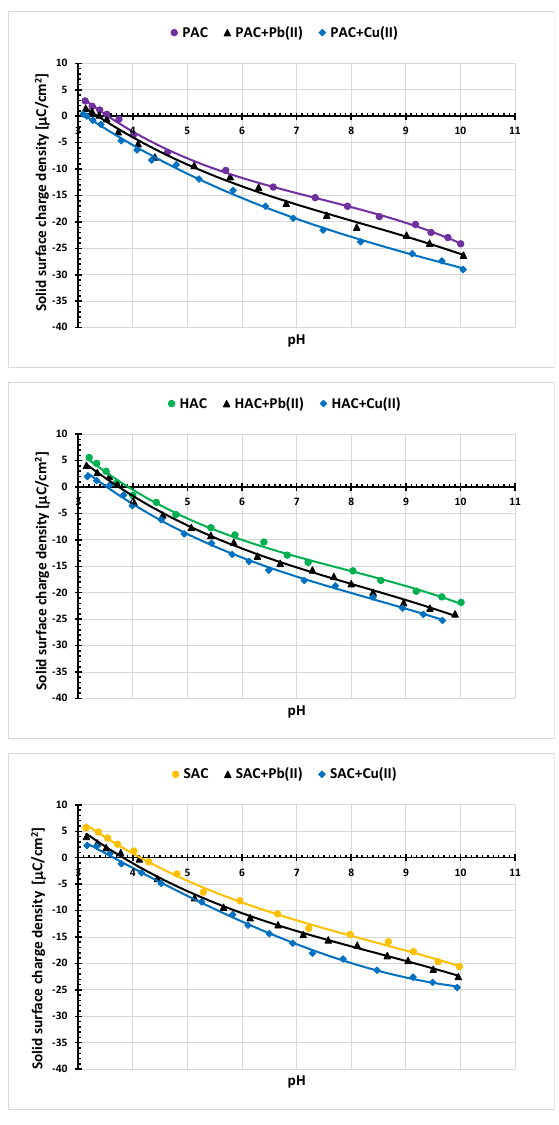
Figure 8. Surface charge density of PAC, SAC and HAC samples without and in the presence of heavy metals ions; C 0 10 mg/dm 3 .